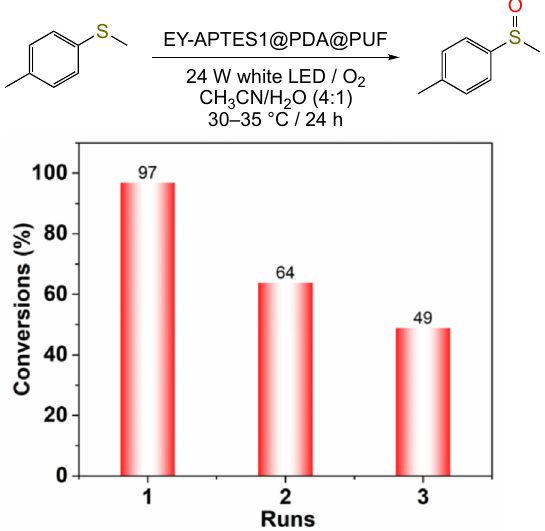
Figure 10. GC conversions measured over three successive runs of p -tolyl methyl sul fi de oxidation photocatalyzed by a single sample of EY-APTES1@PDA@PUF. Reaction conditions: methyl p -tolyl sul fi de (0.5 mmol), EY-APTES1@PDA@PUF (1.5 cm × 1.5 cm × 3 cm), CH 3 CN/H 2 O (4:1) (20 mL), 24